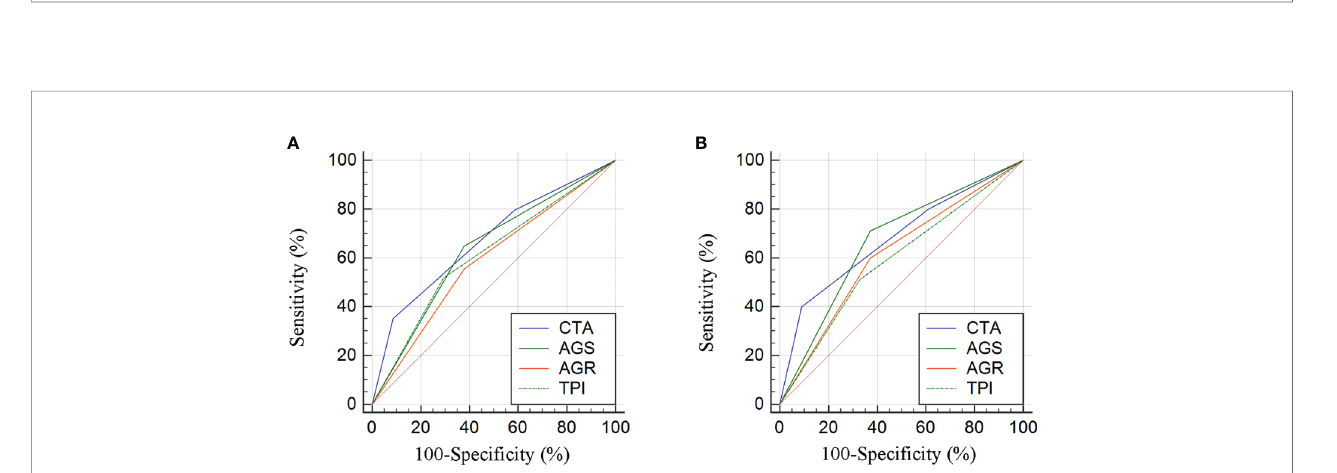
FIGURE 4 | Comparison of area under curves (AUCs) based on the results from receiver operator characteristic (ROC) analyses for AGR, AGS, TPI, and CTA grade in OS and DFS prediction (A, B) .